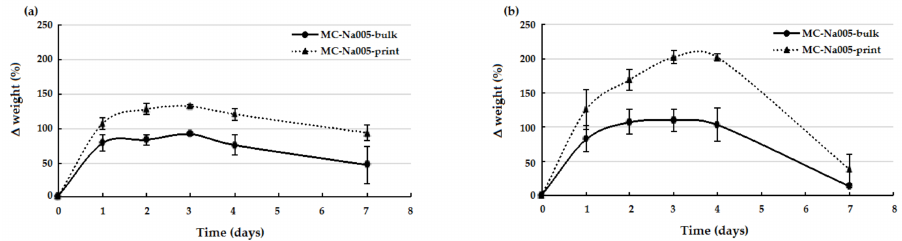
Figure 6. Weight variation ( ∆ W %) versus incubation time in the stability tests performed in distilled water on bulk and printed MC-based hydrogels: ( a ) MC-Na005; ( b ) MC-PBS20.